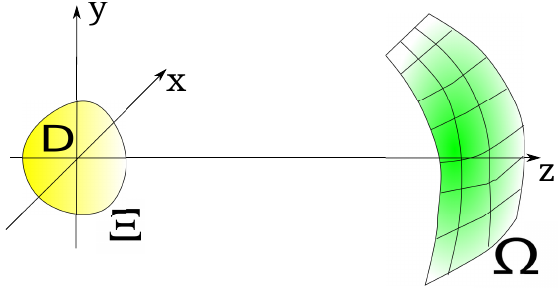
Figure 1. Geometry of the